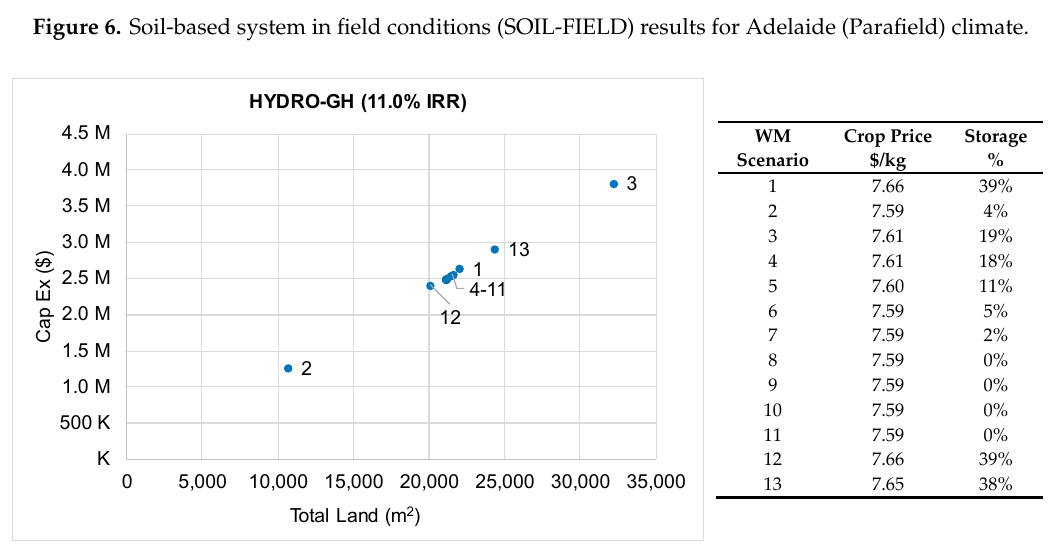
Figure 7. Hydroponic system in greenhouse conditions (HYDRO-GH) results for Adelaide (Parafield) climate. Disposing of 50% of the annual RAS wastewater load to sewer (Scenario 2) approximately halved the land requirement in both SOIL-FIELD and HYDRO-GH, reduced capital expenditure by 80%